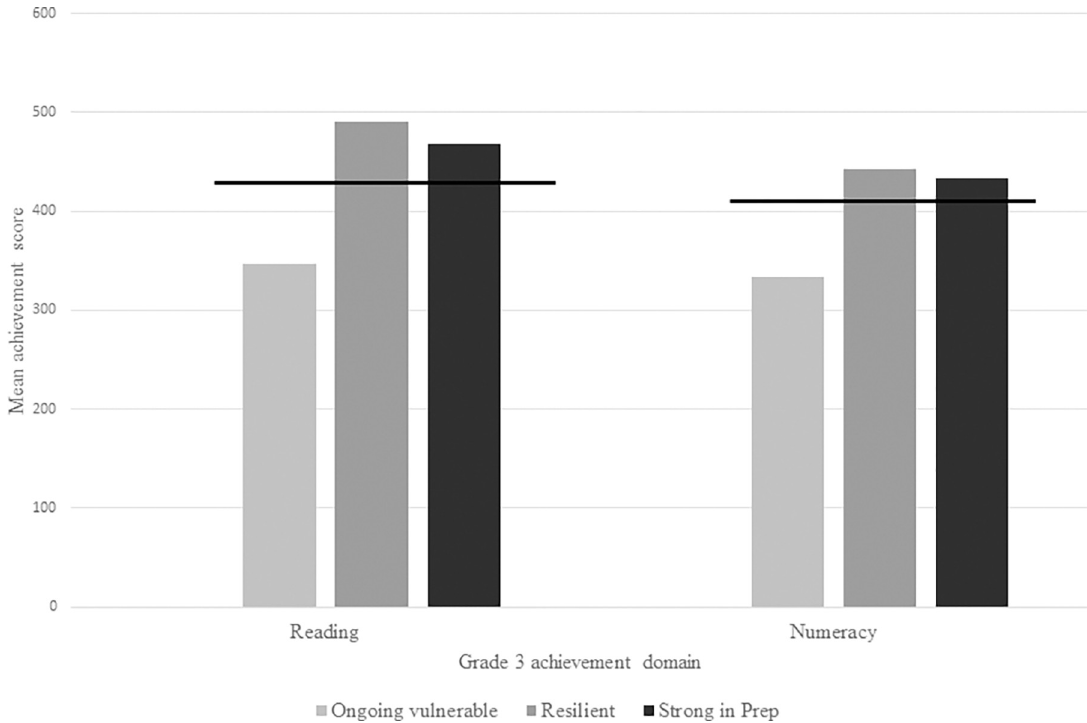
Fig 3. NAPLAN achievement data (Grade 3). Mean Grade 3 achievement scores in each domain for children identified as ongoing vulnerable, resilient, and strong in Prep. Horizontal black lines show Grade 3 level equivalent scores published by the Grattan institute based on 2014 NAPLAN achievement data [39], for the reading and numeracy domains. These show that both resilient and strong in Prep children performed above Grade 3 equivalent